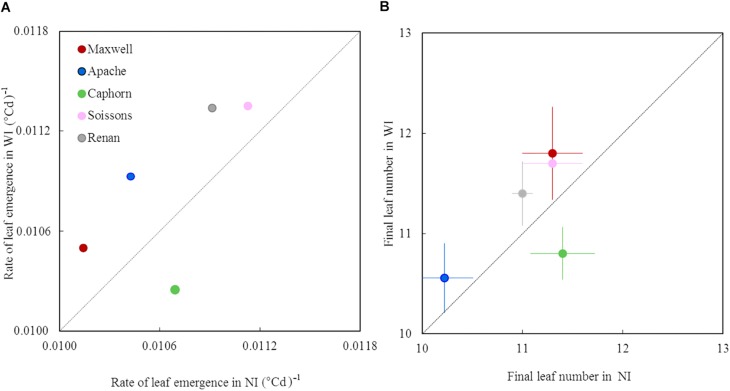
The rate of leaf emergence and the final leaf number of the main stem in WI treatments vs. NI treatments. Each color is associated with a cultivar, as indicated in the legend. The value of the rate of leaf emergence (A) was estimated from a linear model adjusted on the mean estimates of leaf stage. The data for final leaf number (B) are the mean values measured on 10 tagged plants, with error bars representing 95% confidence intervals of mean estimates. The dotted line represents the line 1:1.